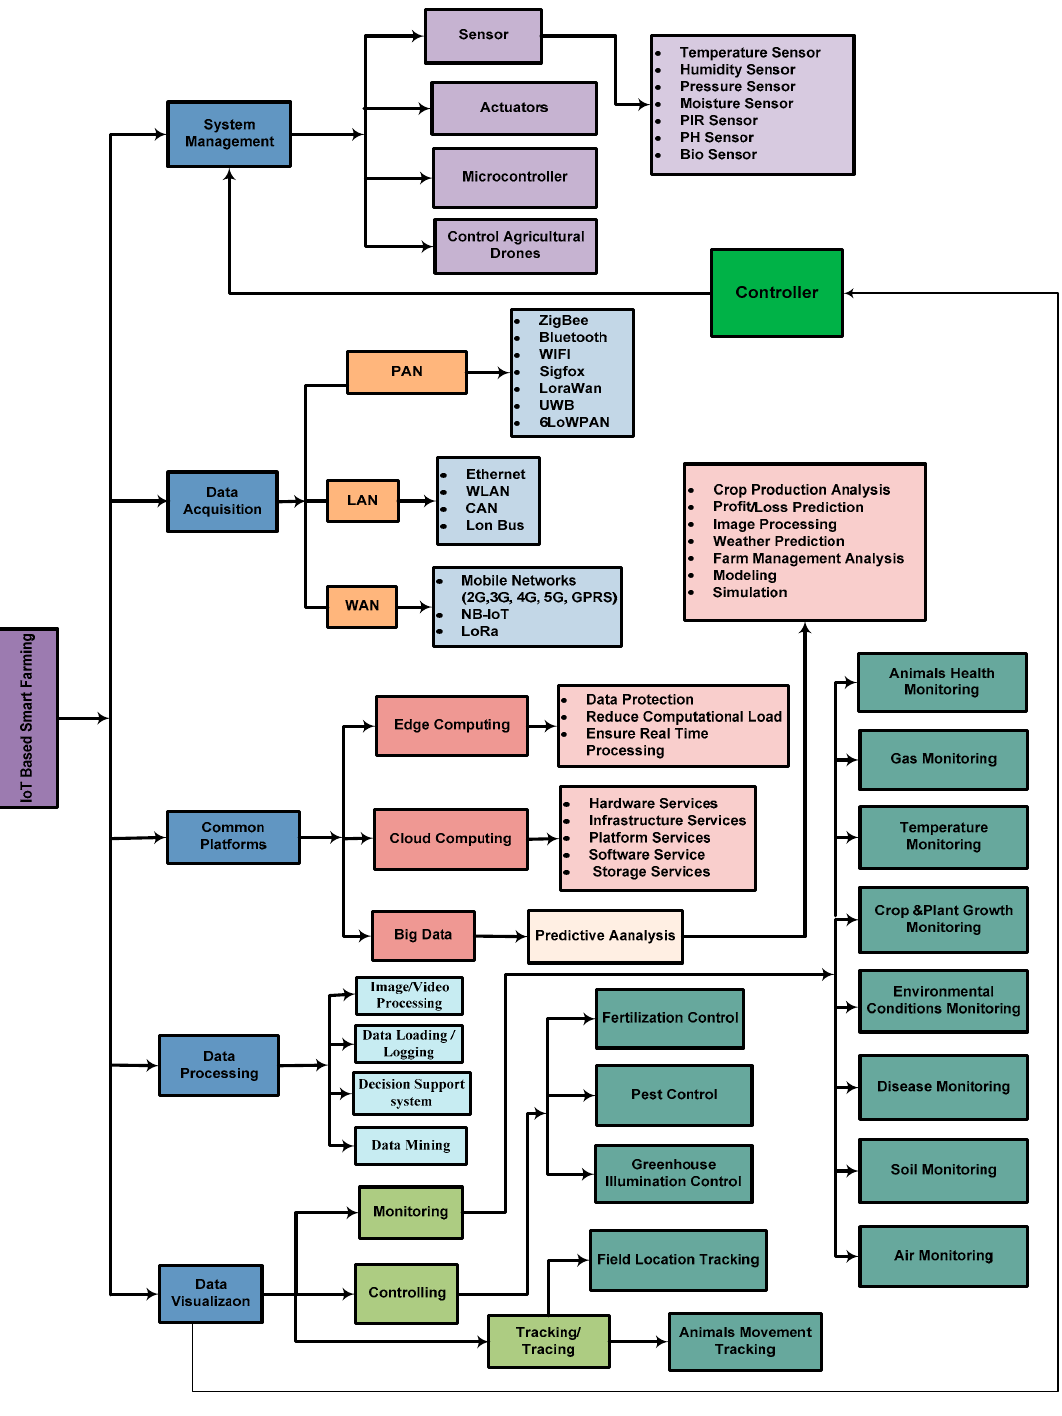
Figure 9. IoT smart farming framework.